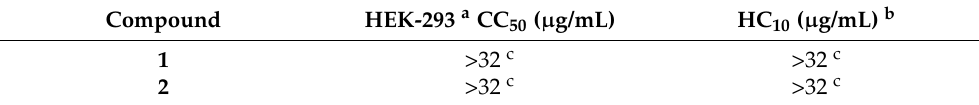
Table 3. Cytotoxicity and haemolytic properties of 1 and 2 .